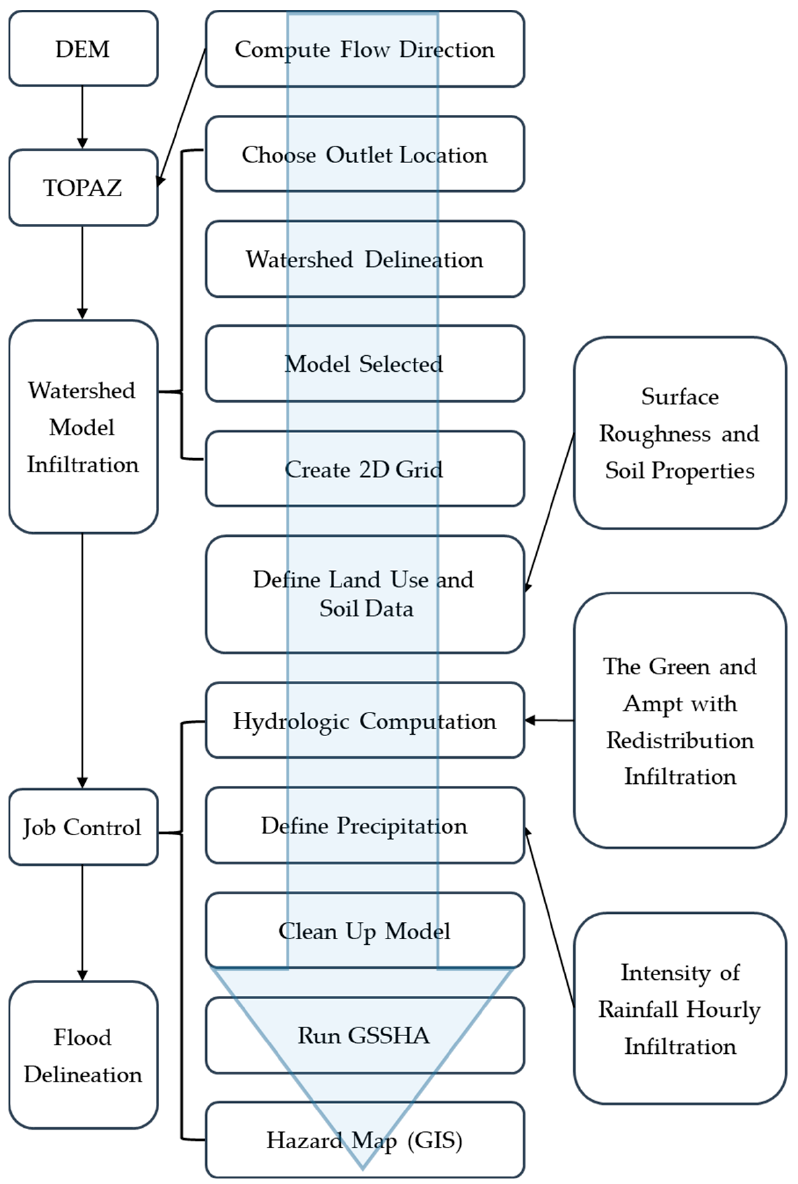
Figure 3. Simulation steps.